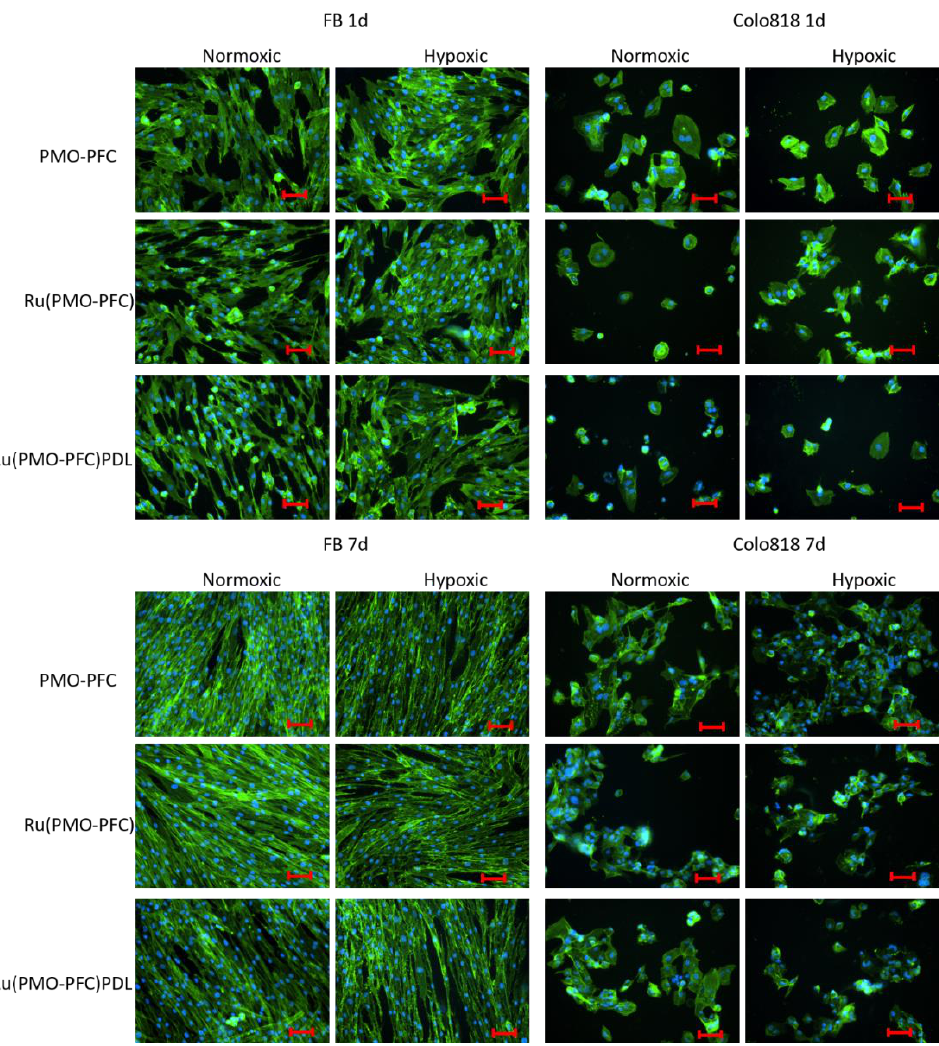
Figure 6. Fluorescence images of FB and colo818 cells on PMO-PFC-, Ru(PMO-PFC)-, and Ru(PMO- PFC)PDL-coated culture plate under normoxic and hypoxic conditions for 1 d and 7 d incubation time. Scale bar equal to 50 µm.